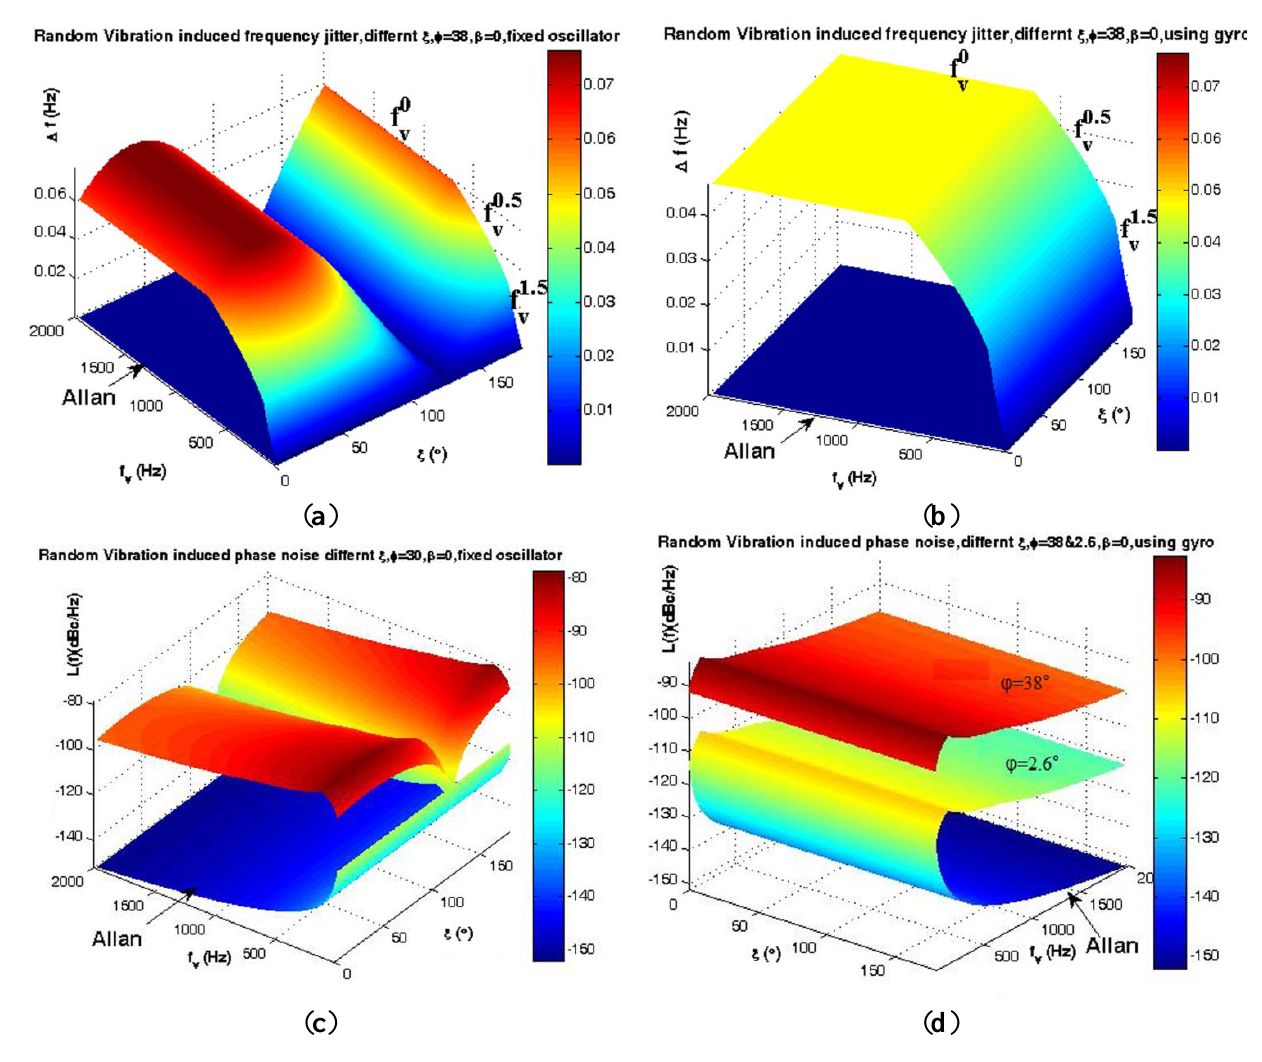
Figure 26. Analysis of random vibration in frequency domain for 0° < |ξ | < 180°, β = 0, φ = 2σ = 38°.( a ) Frequency jitter of fixed oscillator; ( b ) Frequency jitter of gyroscopic mounting; ( c ) Phase noise of fixed oscillator; ( d ) Phase noise of gyroscopic